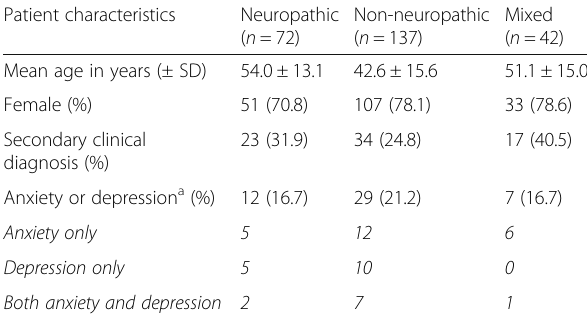
Table 1 Patients characteristics grouped by pain type Patient